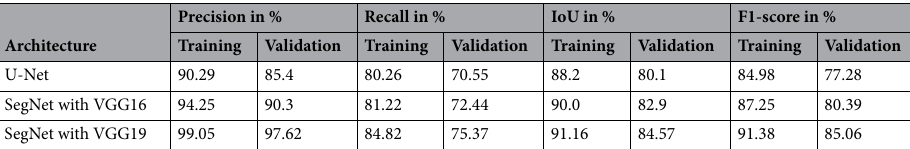
Table 3. Performance comparison with other